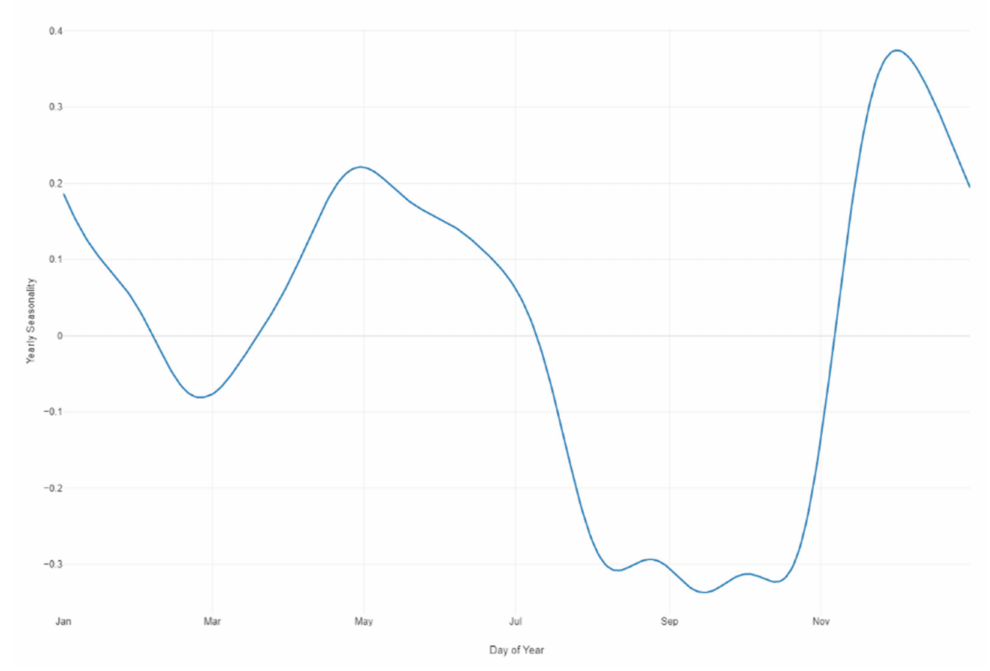
Figure 32. Prophet forecast yearly seasonality.